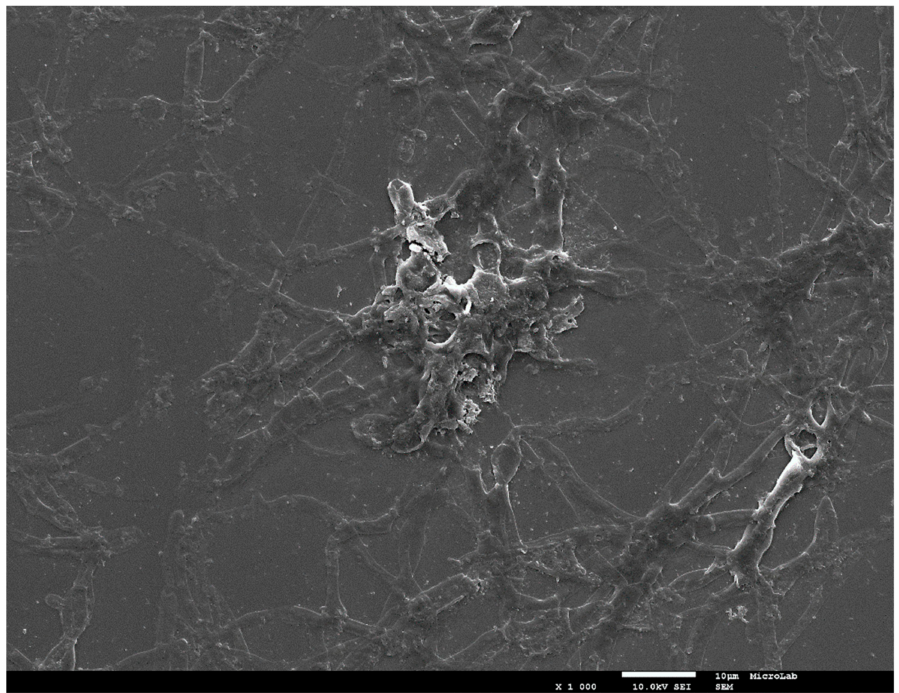
Figure 3. SEM micrography with fungi hyphae on top of glass and hyphae fingerprints (image taken from Ref. [39] with permission of the